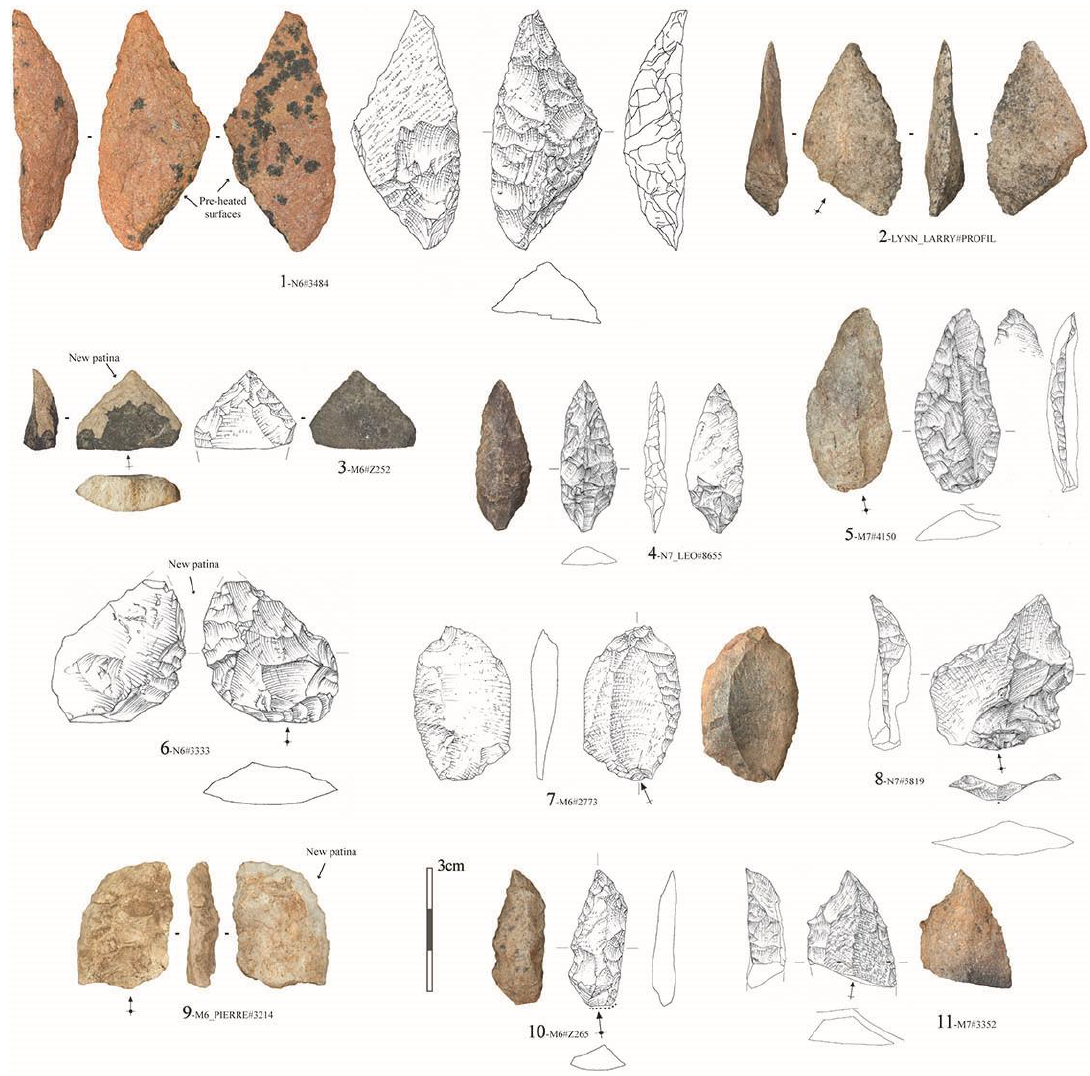
Figure 9 . Formal tools from the stratigraphic unit Lynn at Diepkloof Rock Shelter. N°1: unifacial point shaped on a heat-treated silcrete flake with bifacial proximal shaping. N°2, 6: unifacial point. N°3: unifacial point of Tongati type; the retouch shows a recent patina. N°4: unifacial point with bifacial proximal shaping. N°5, 7, 8, 10, 11: unifacial points. N°9: lateral scraper; the retouch shows a recent patina. All silcrete except n°9: quartz. N° 4 has been discovered at the contact with the overlying stratigraphic unit Leo. (Drawings Michel Grenet). A high resolution version of this figure is available at